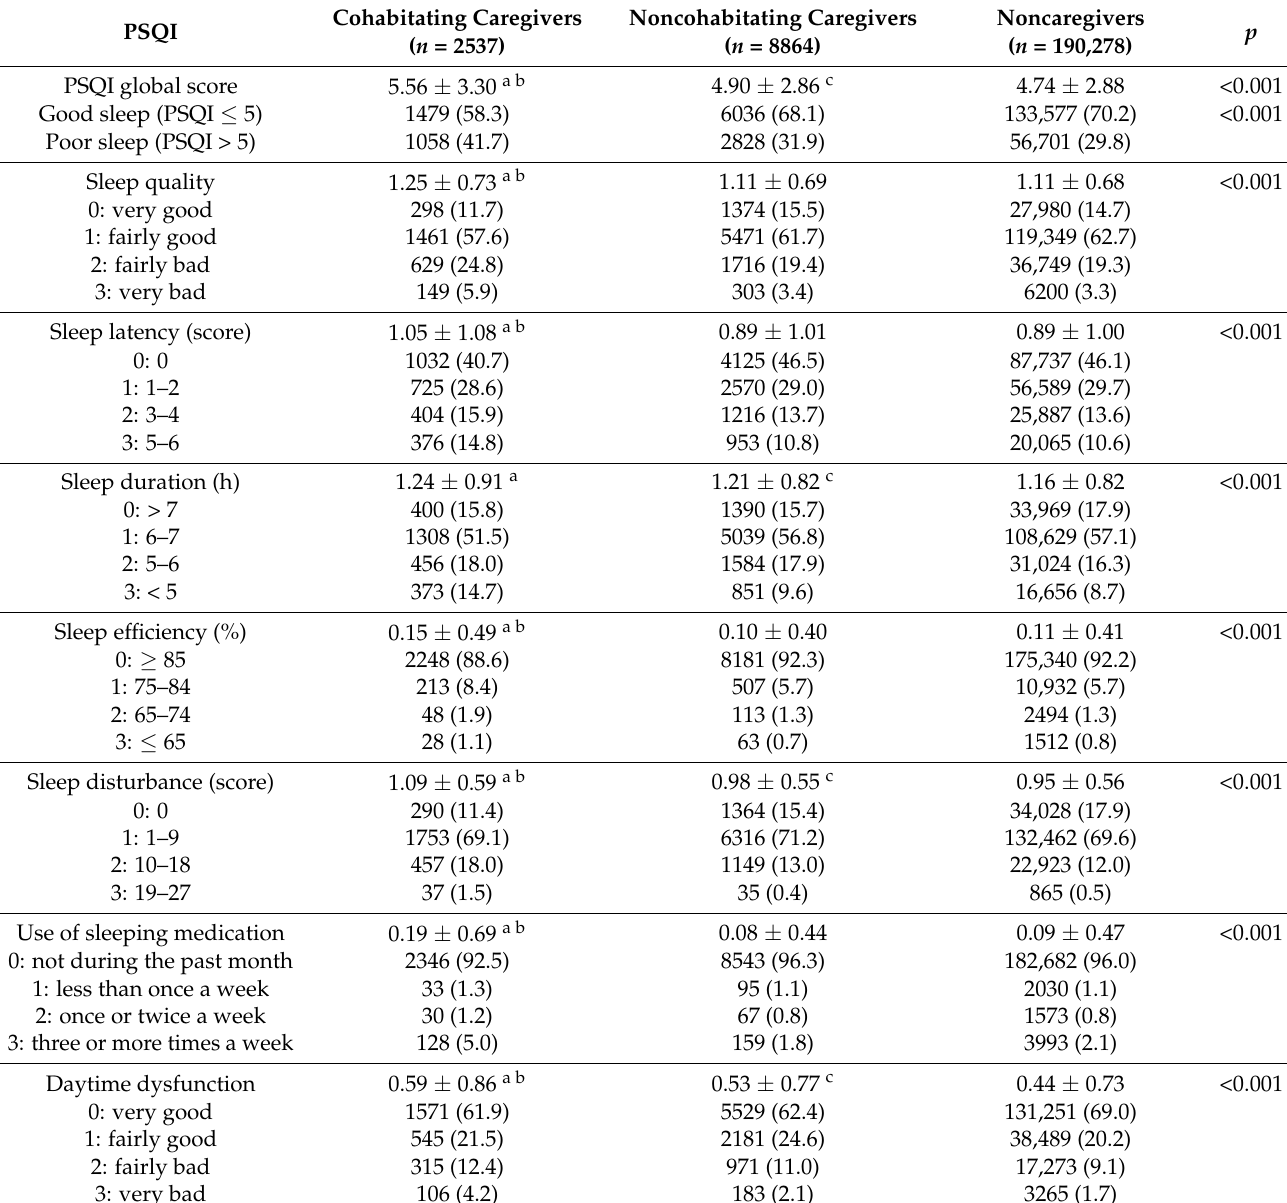
Table 2. Comparisons of global PSQI and seven component scores among cohabitating caregivers, noncohabitating caregivers, and